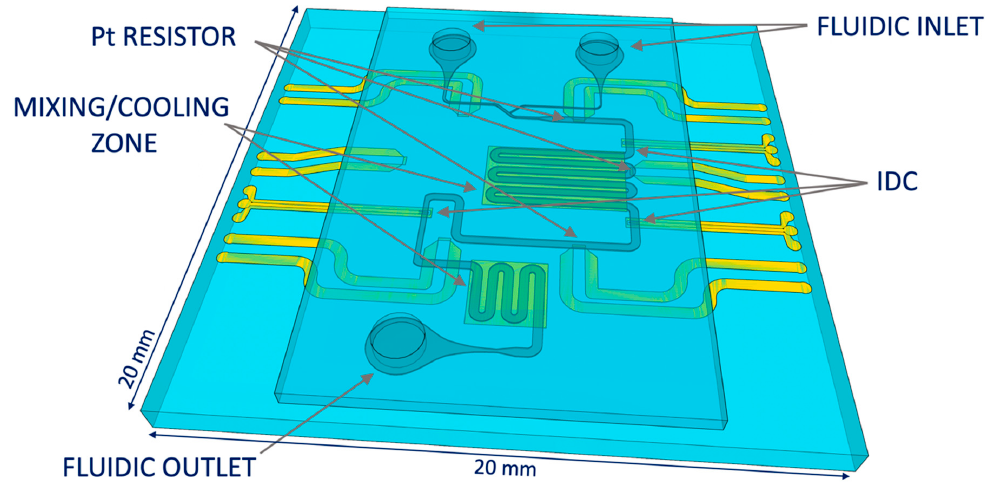
Figure 4. The microwave-microfluidic chip with three IDC microwave heaters, three platinum temperature sensors, two cooling pads and a fluidic channel with a T-junction.